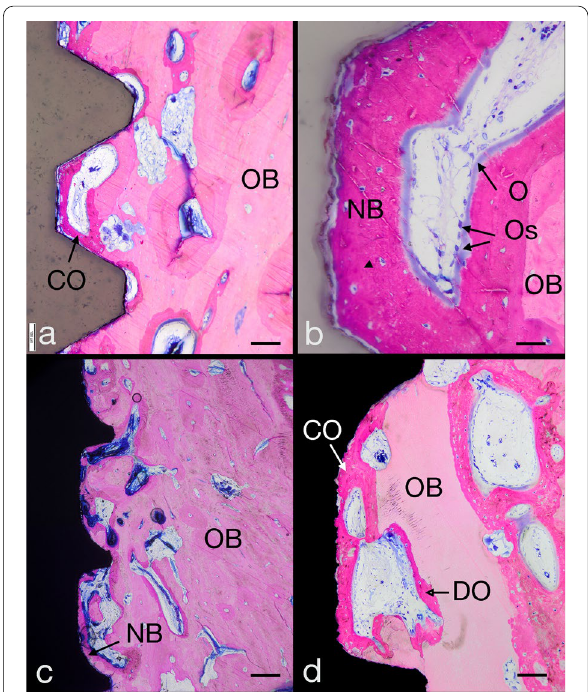
Fig. 4 LM micrographs demonstrating the status of osseointegration after 4 weeks with YTZP implants ( a , b ) and Ti-SLA implants ( c , d ). Note the presence of distance osteogenesis (DO), outgoing from local bone, and contact osteogenesis (CO), outgoing from contact points between local bone with the implant. Also note the presence of an osteoid (O) lined with osteoblasts (OB), indicating ongoing bone formation ( b , d ). Scale bars: ( a and c ) 100 µm; ( b and d ) 300